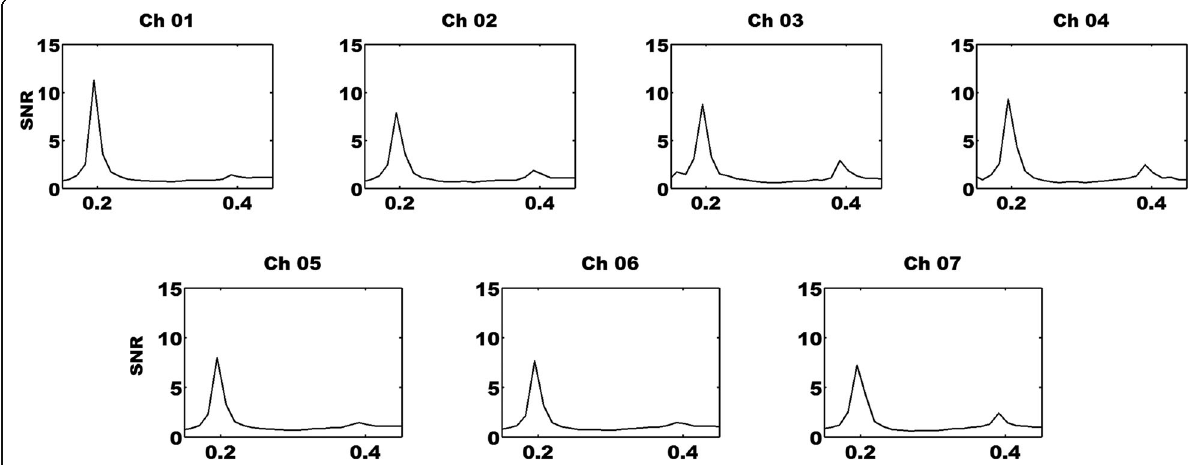
Fig. 4 The frequency domain grand-averaged LFHO signals across all conditions and participants during periodic FE stimuli with SSVEP. The unit of x -axis is Hz in frequency while the y -axis has no